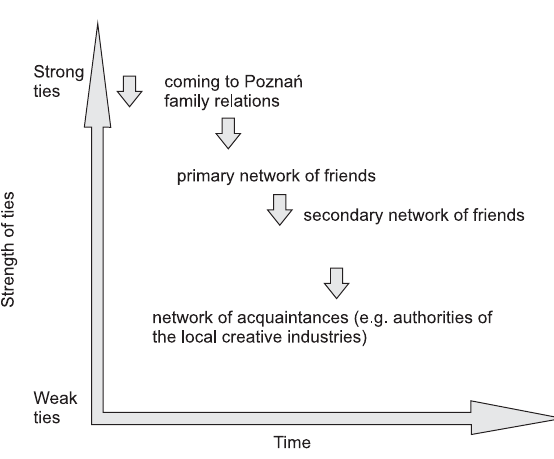
Fig. 2. Development of personal networks of creative international